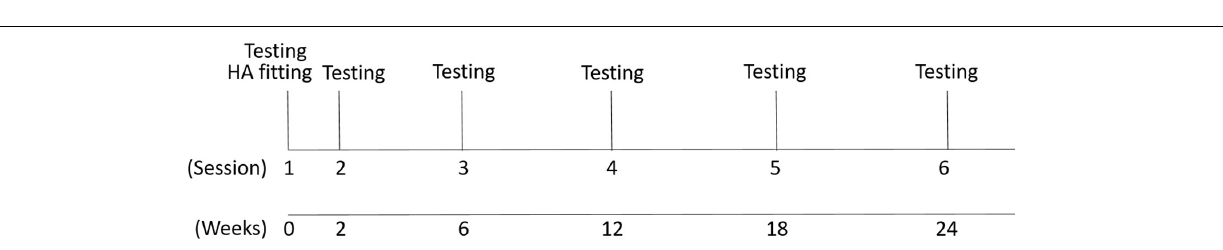
FIGURE 2 | Study design. Six testing sessions were conducted. The first session included the hearing aid fitting and EEG recording and the second to sixth sessions (EEG recording and hearing aid checks of data logging) were conducted after the hearing aid fitting in time intervals shown in